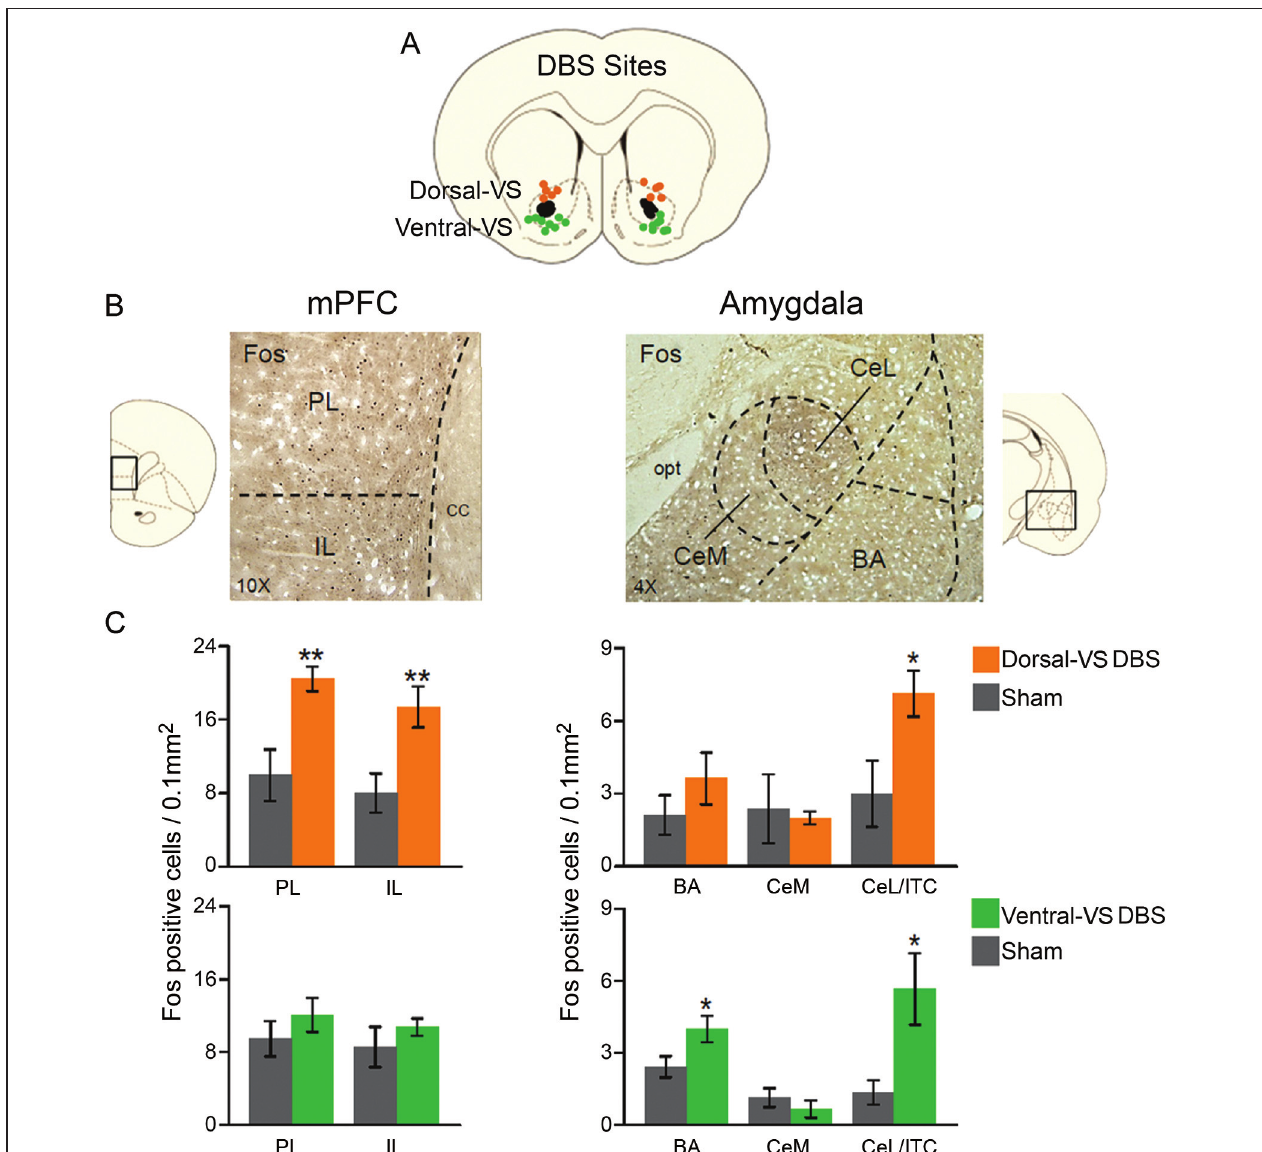
magnification, right). (C) DBS of dorsal-VS increased Fos expression in PL, IL and CeL/ITC, but not in BA or CeM (Sham, n = 5; DBS of dorsal-VS, n = 4). In contrast, DBS of ventral-VS increased Fos in the basal nucleus of the amygdala (BA) and CeL/ITC, but not in PL, IL or CeM (Sham, n = 8; DBS of ventral-VS, n = 8). Legend: CeM = medial portion of the central nucleus of the amygdala, cc = corpus callosum, opt = optic tract. Data shown as mean and SEM. ∗ p < 0.05 ∗∗ p <